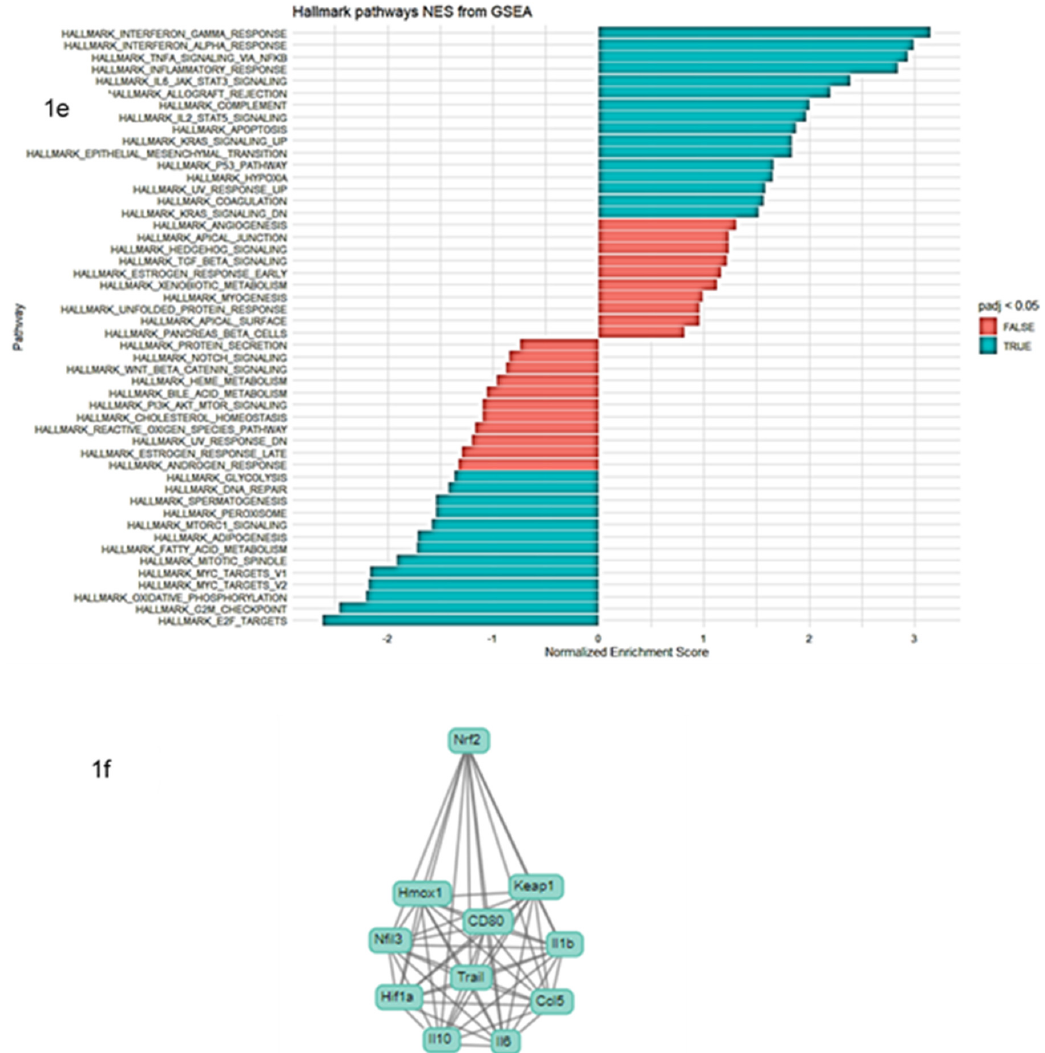
Figure 1. The hypoxia pathway is not activated in LPS treated macrophages. ( 1a ) The PCA analysis indicates a clear separation between LPS treated cells versus controls. ( 1b ), ( 1c ) Many proinflammatory genes were upregulated in LPS+ cells while hypoxia related genes were not upregulated. ( 1d ) Heat map of inflammatory pathway versus hypoxia and reactive oxygen species pathway. ( 1e ) Pathway enrichment indicating that LPS+ cells have a proinflammatory profile. ( 1f ) The gene analysis network shows that Nrf2 is putatively influencing all the chosen genes.